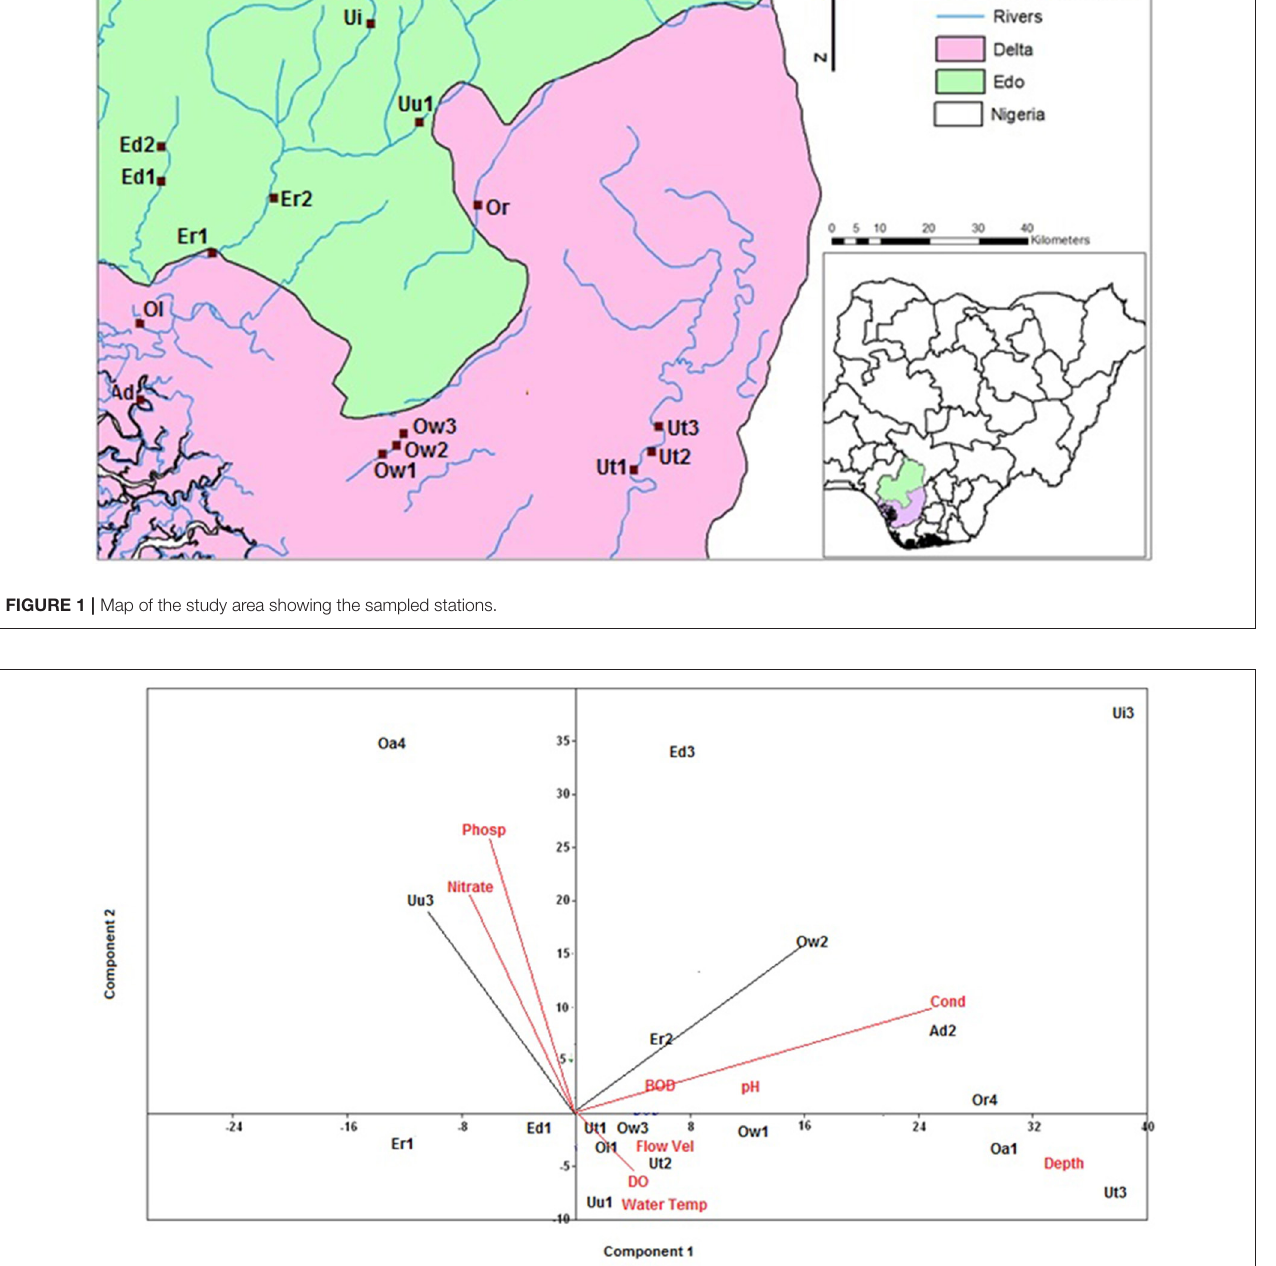
Frontiers in Water |